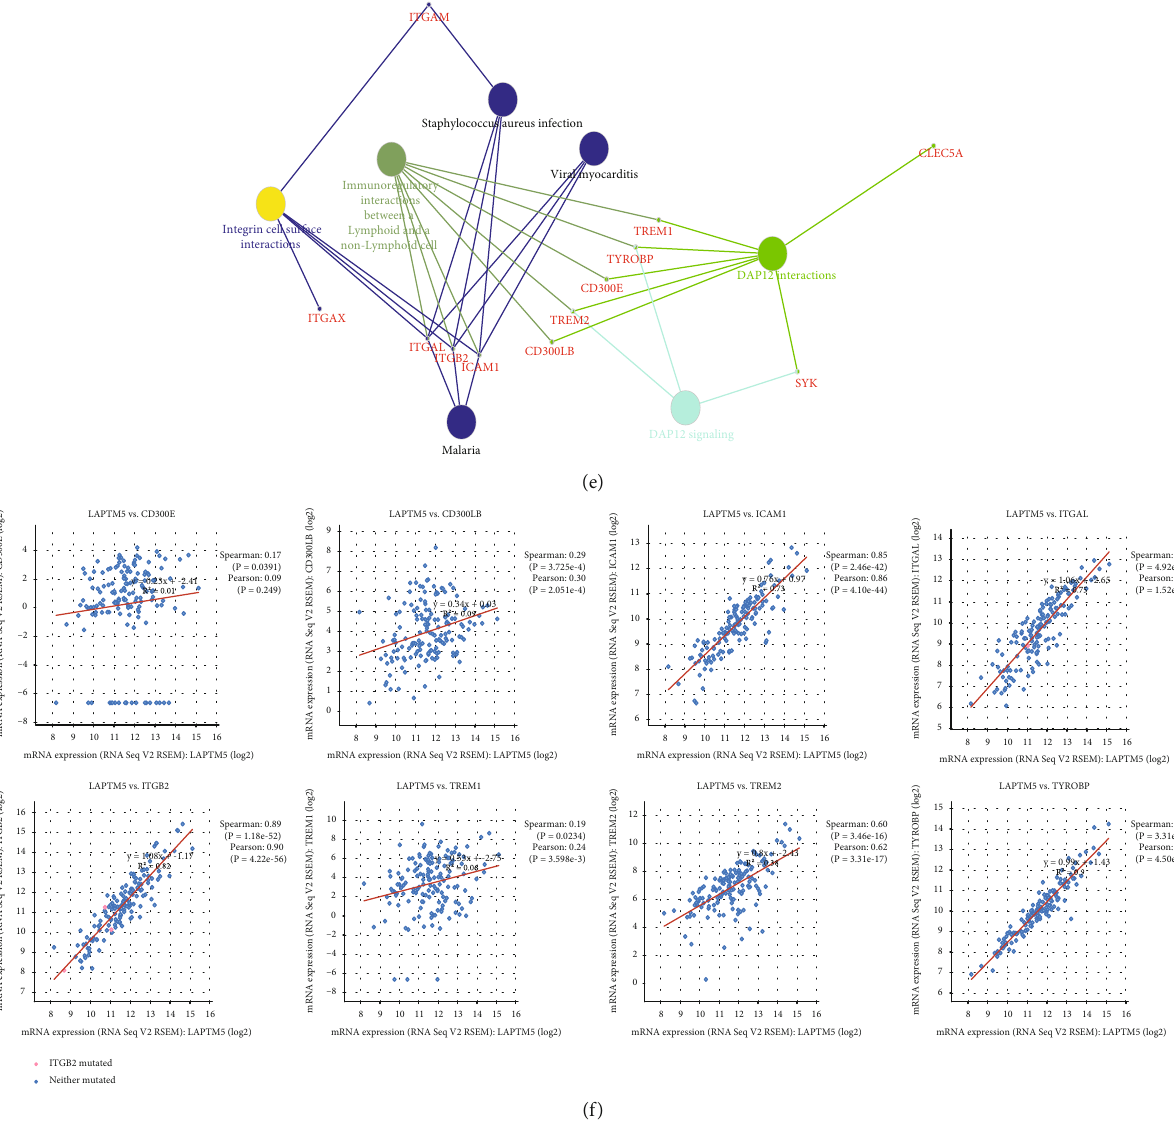
Figure 6: Schematics of the hub genes. (a) Top 40 hub genes by degree. (b) Venn diagram for the hub gene intersection. (c) The pan-cancer expression for LAPTM5. ∗ P < 0 : 05 , ∗∗ P < 0 : 01 , ∗∗∗ P < 0 : 001 . (d) Protein-protein interaction network for LAPTM5 and its related gene. (e) Pathway analysis for LAPTM5 and its related gene. (f) The relationship between the co-expression of LAPTM5 and its related genes. P values are